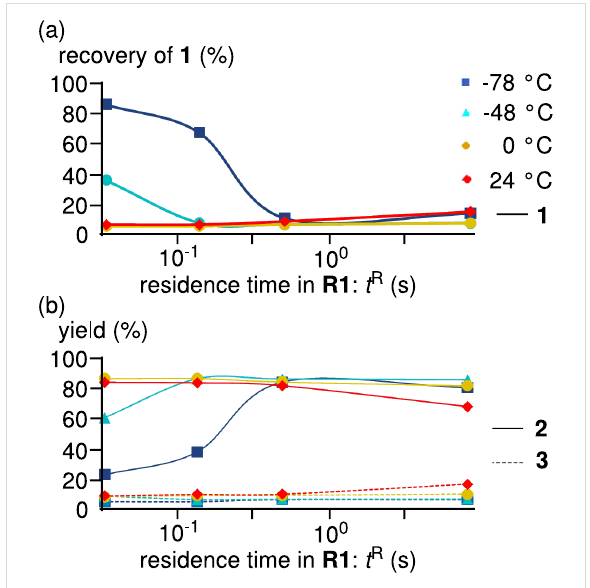
Figure 2: Effect of temperature and residence time in Br-Li exchange reaction of 2,2′-dibromobiphenyl ( 1 ) using the microflow system; (a) plots of recovery of 1 against the residence time, (b) plots of yields of 2 and 3 against the residence time. Flow rate of a solution of 2,2′-dibro- mobiphenyl ( 1 ): 6.00 ml·min −1 , flow rate of n -BuLi: 1.20 ml·min −1 , flow rate of methanol: 3.00 ml·min −1 . Yields of 1 , 2 and 3 were determined by